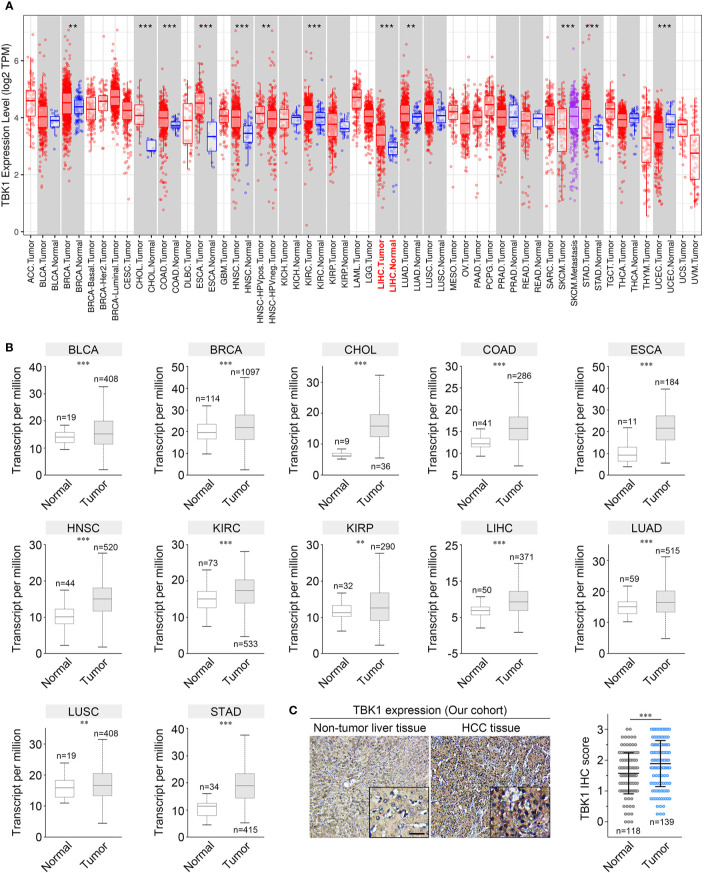
TANK-binding kinase 1 (TBK1) expression levels in human cancer. The levels of TBK1 mRNA expression in different types of human cancer were determined using Tumor Immune Estimation Resource (TIMER) (A) and UALCAN (B). (C) Representative images of immunohistochemistry (IHC) staining with a TBK1 antibody on HCC tissues (n = 138) and corresponding normal tissues (n = 118) in our cohort. ACC, Adrenocortical carcinoma; BLCA, Bladder urothelial carcinoma; BRCA, Breast invasive carcinoma; BRCA-Basal/Her2/Luminal, Breast invasive carcinoma-Basal/Her2/Luminal; CESC, Cervical squamous cell carcinoma and endocervical adenocarcinoma; CHOL, Cholangiocarcinoma; LIHC, Liver hepatocellular carcinoma; COAD, Colon adenocarcinoma; READ, Rectum adenocarcinoma; DLBC, Lymphoid neoplasm diffuse large B-cell lymphoma; LAML, Acute myeloid leukemia; ESCA, Esophageal carcinoma; GBM, Glioblastoma multiforme; LGG, Brain Lower Grade Glioma; HNSC, Head and neck squamous cell carcinoma; HNSC- HPVneg, Head and neck squamous cell carcinoma-HPVneg; KICH, Kidney chromophobe; KIRC, Kidney renal clear cell carcinoma; KIRP, Kidney renal papillary cell carcinoma; LUAD, Lung adenocarcinoma; LUSC, Lung squamous cell carcinoma; MESO, Mesothelioma; OV, Ovarian serous cystadenocarcinoma; PAAD, Pancreatic adenocarcinoma; PCPG, Pheochromocytoma and Paraganglioma; PRAD, Prostate adenocarcinoma; SARC, Sarcoma; SKCM, Skin cutaneous melanoma; SKCM-Metastasis, Skin cutaneous melanoma- Metastasis; STAD, Stomach adenocarcinoma; TGCT, Testicular Germ Cell Tumors; THCA, Thyroid carcinoma; THYM, Thymoma; UCEC, Uterine Corpus Endometrial Carcinoma; UCS, Uterine Carcinosarcoma; UVM, Uveal Melanoma. *P < 0.05; **P < 0.01; ***P < 0.001.